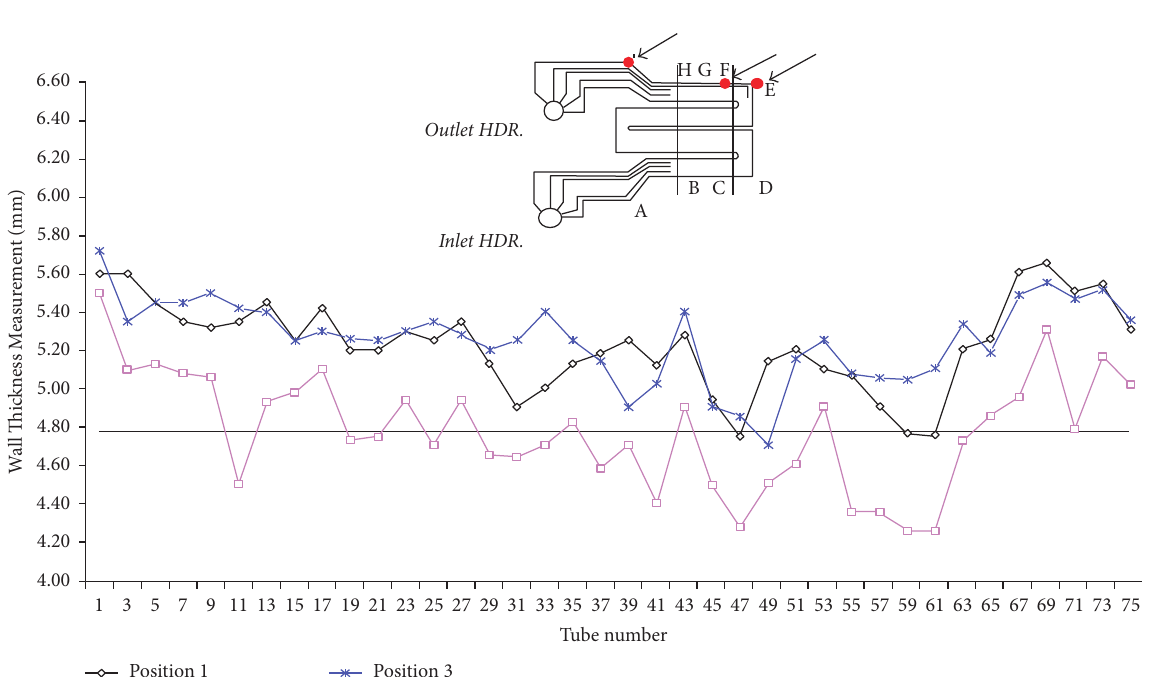
Figure 14: Schematic of the final superheater with determined critical points and thickness values of the tubes in zone E.